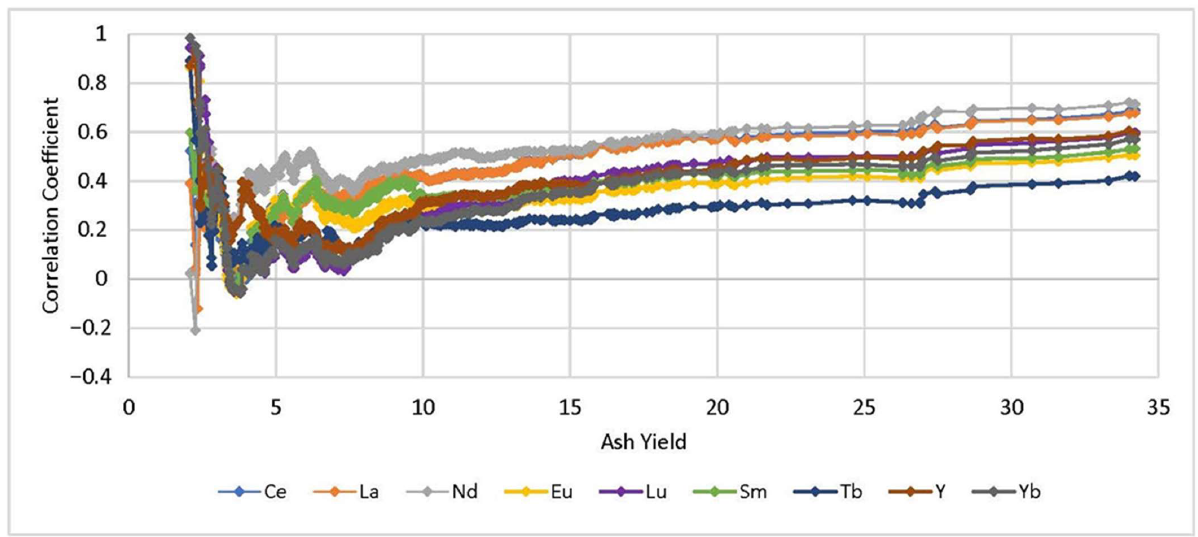
Figure 4. Progressively calculated correlation coefficients between rare earth elements and yttrium (REY) and increasing ash yield (%).